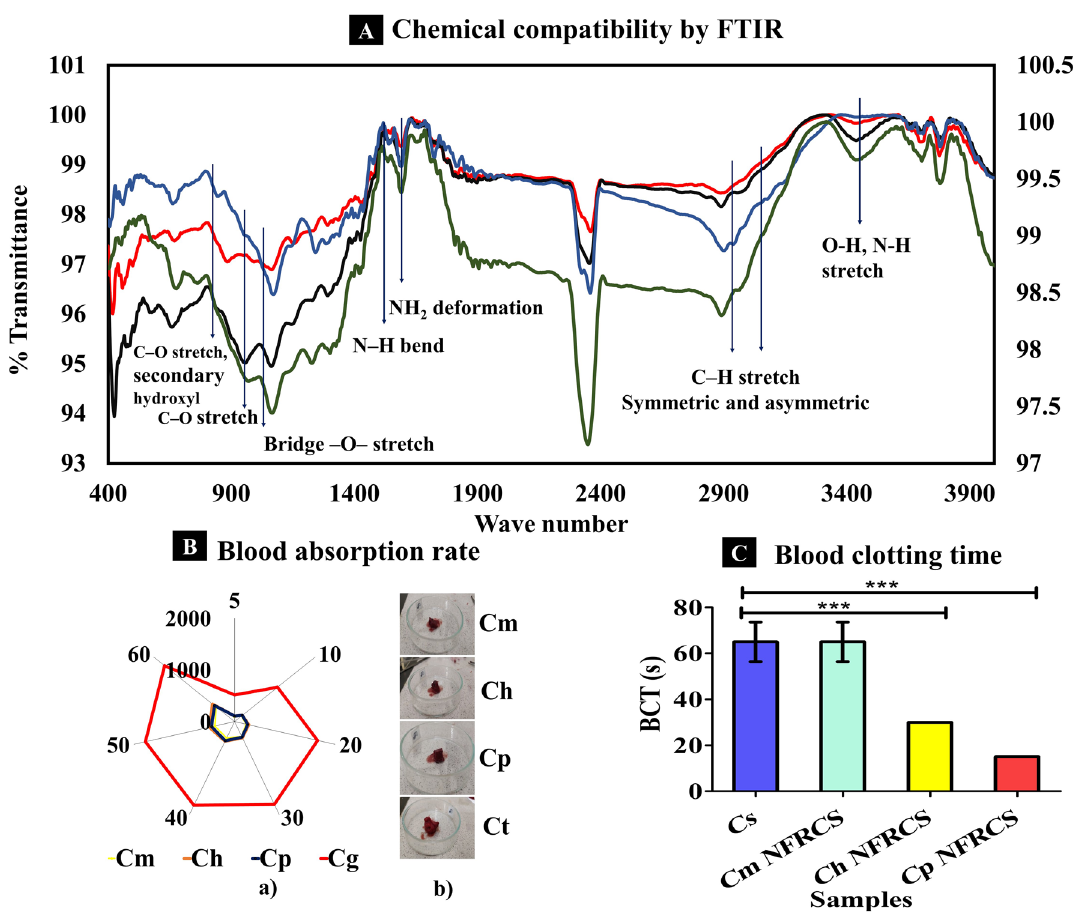
Figure 2. In vitro characterization features of Cm NFRCS, Ch NFRCS, Cp NFRCS, and Cs. ( A ) Represents the combined FTIR spectrum of chitosan and Cm NFRCS, Ch NFRCS, and Cp NFRCS formulations in compression. ( B ) a) The whole blood absorption rate of NFRCS of Cm, Ch, Cp, and Cg, (n = 3); The Ct sample showed high BAR as the cotton gauge has high imbibing efficiency; b) Pictorial representation of blood- absorbed samples after blood absorption. C The graphical representation of BCT of test samples (Cp NFRCS has the best BCT (15 s, n = 3)). Data in C, D, E, and G were shown as mean ± SD, and the error bars represent SD, *** p <